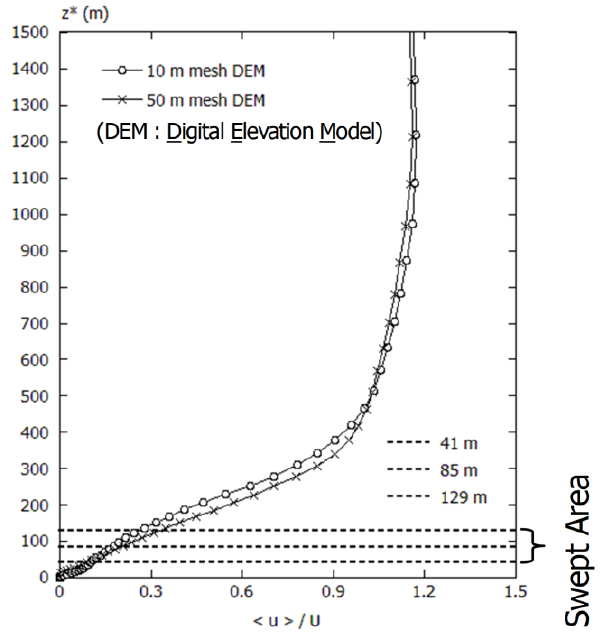
Figure 11. Profiles of mean streamwise wind velocity at Wind Turbine No. 17.